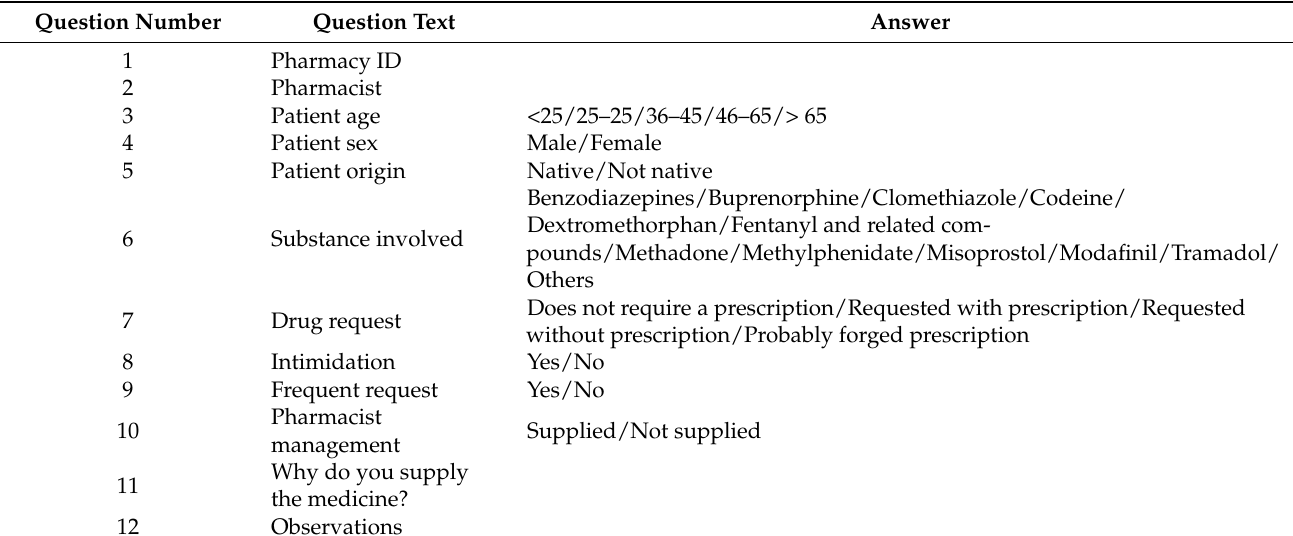
Table 1. Abuse Drug Questionnaire (ADQ) used for the surveillance system